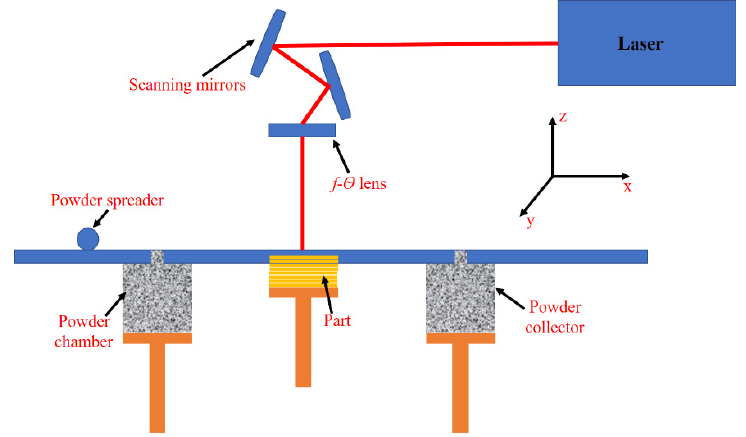
Figure 1 . Schematic of the laser powder bed fusion process. Figure 1. Schematic of the laser powder bed fusion